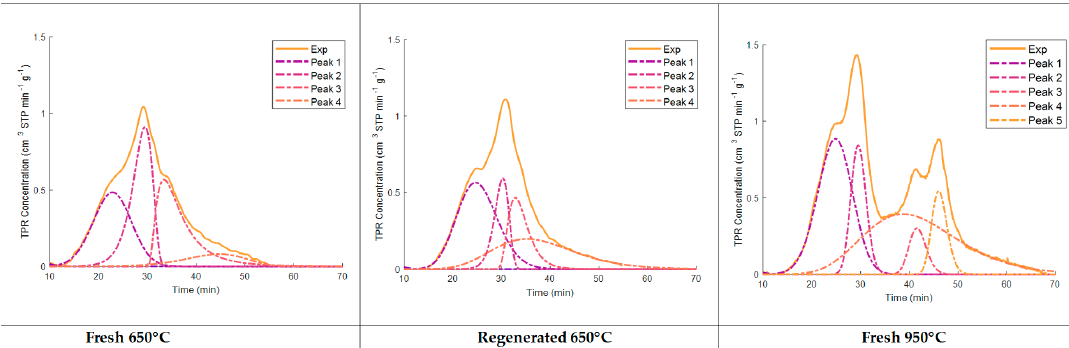
◦ C and 950 ◦ / CaO- γ -Al 2 O 3 catalyst at 650